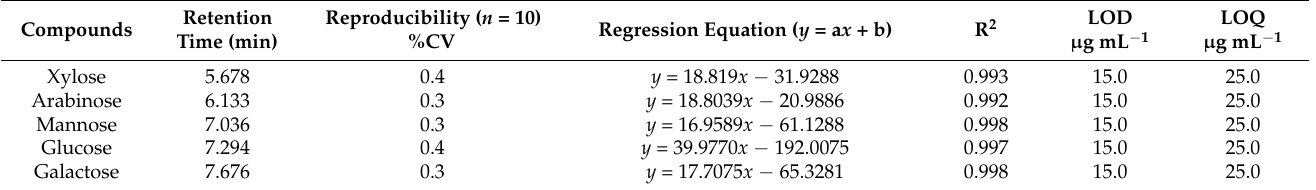
Figure 5. UHPLC–ELSD chromatogram of the carbohydrate sample (1—xylose, 2—arabinose, 3—mannose, 4—glucose, 5—galactose, 6—HMF, 7—furfural). Table 9. Linearity, limit of detection (LOD), limit of quantification (LOQ), correlation coefficient (R 2 ), and reproducibility of sugars.